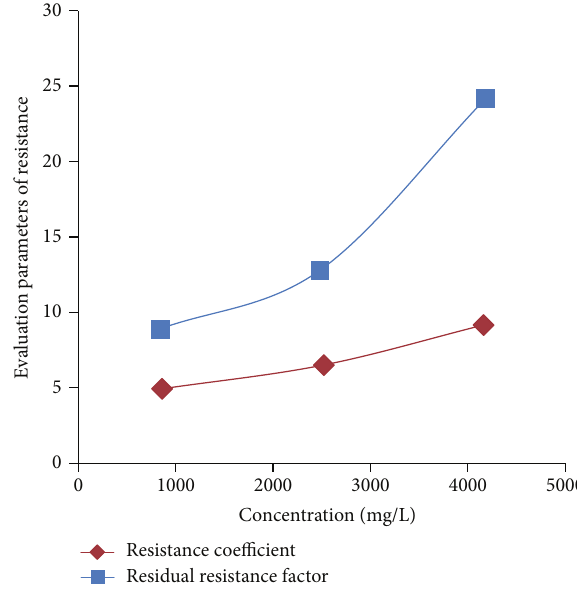
Figure 8: Relationship between resistance evaluation parameters and asphalt particles concentration (2000 mD).